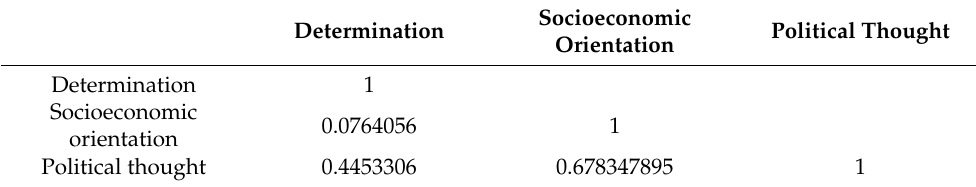
Table 6. The correlation matrix of the measures of entrepreneurial qualities.